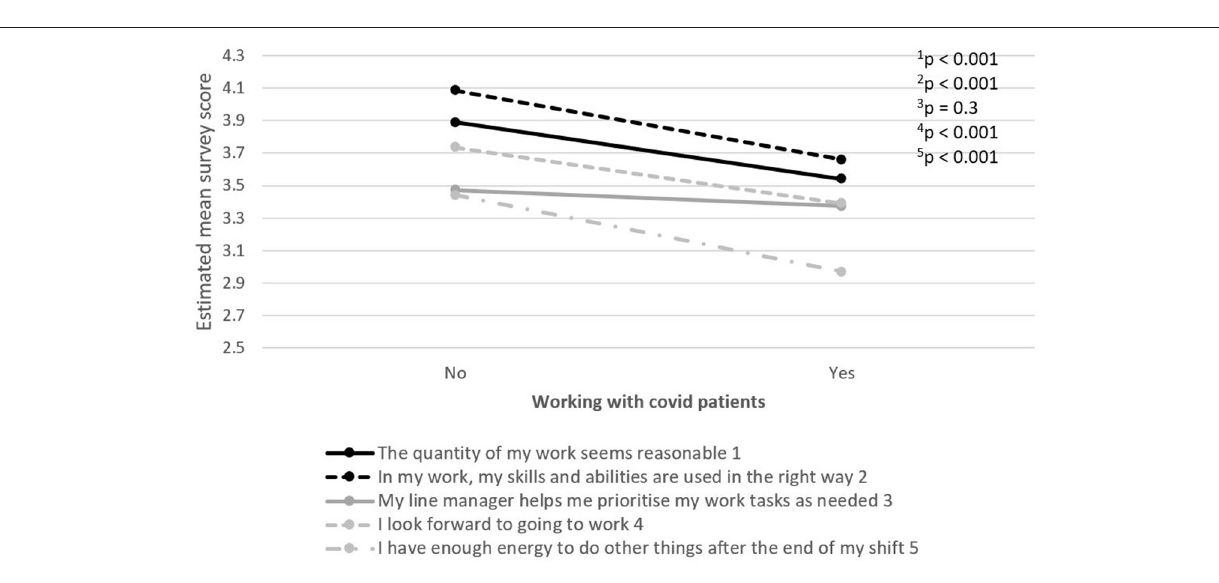
FIGURE 4 | The relationship between five selected work environment items in terms of job demands and resources, motivation and possibility for recovery, and working with patients with COVID-19. The item’s survey score ranges between 1 (strongly disagree) and 5 (strongly